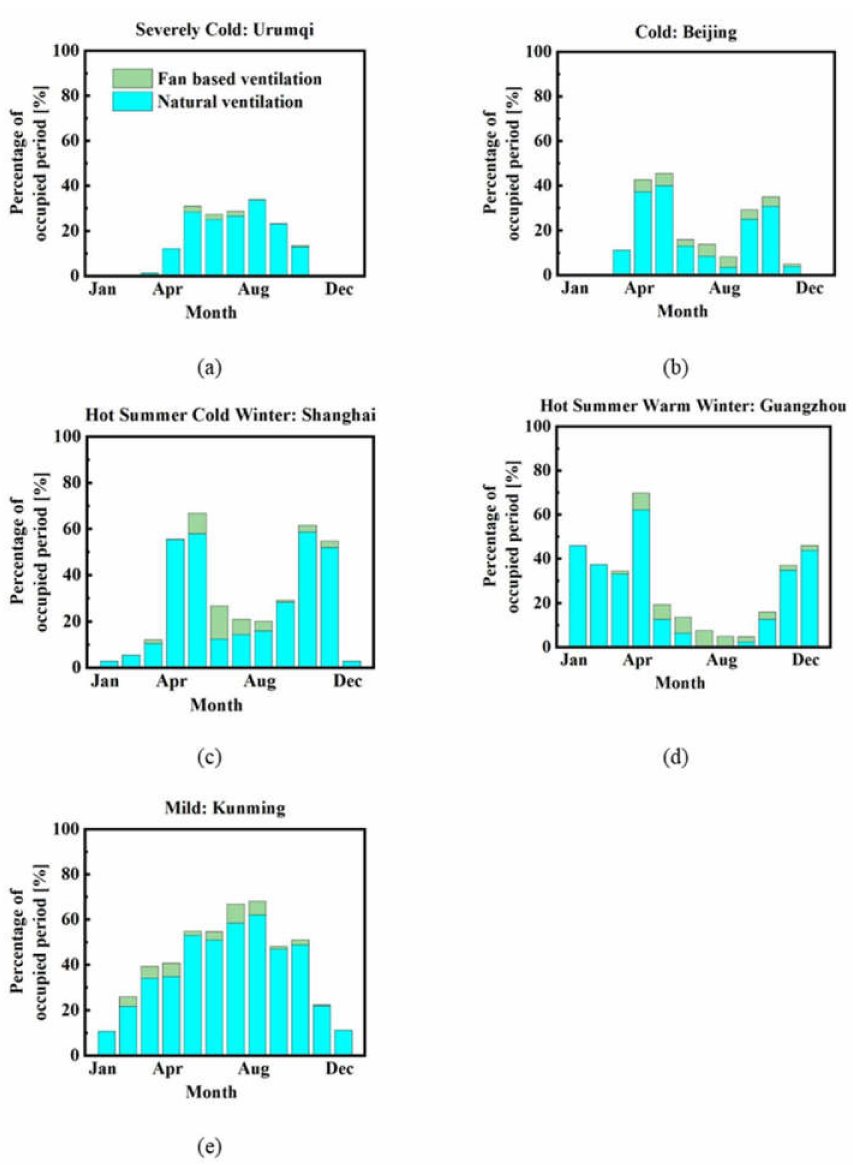
Figure 4. Percentage of occupied period in each month when natural ventilation and purely fan- based ventilation were sufficient to maintain an acceptable indoor thermal environment, at an indoor equipment load of 50 W/m 2 in different climate zones: ( a ) severely cold; ( b ) cold; ( c ) hot summer cold winter; ( d ) hot summer warm winter; ( e )